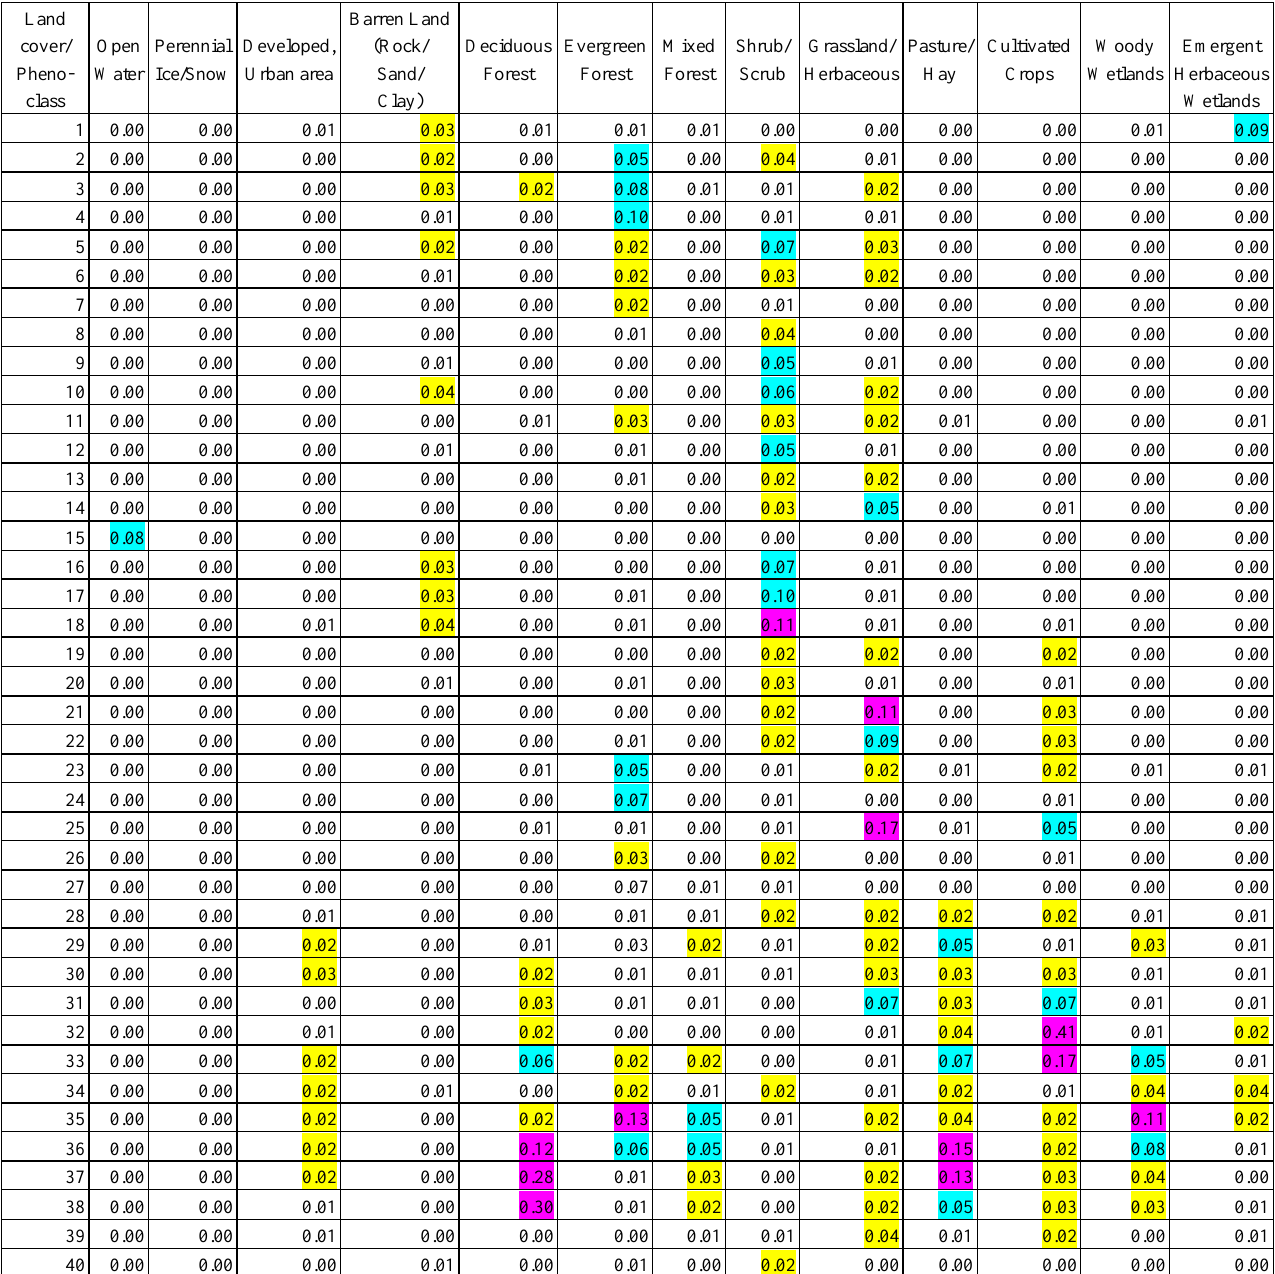
Table 2. C values show the degree of overlap for each combination of pheno-class and m NLCD-based land cover class. C values ranges 0.02–0.05, 0.05–0.1, and 0.1–0.5 are m highlighted in yellow, aqua, and pink,